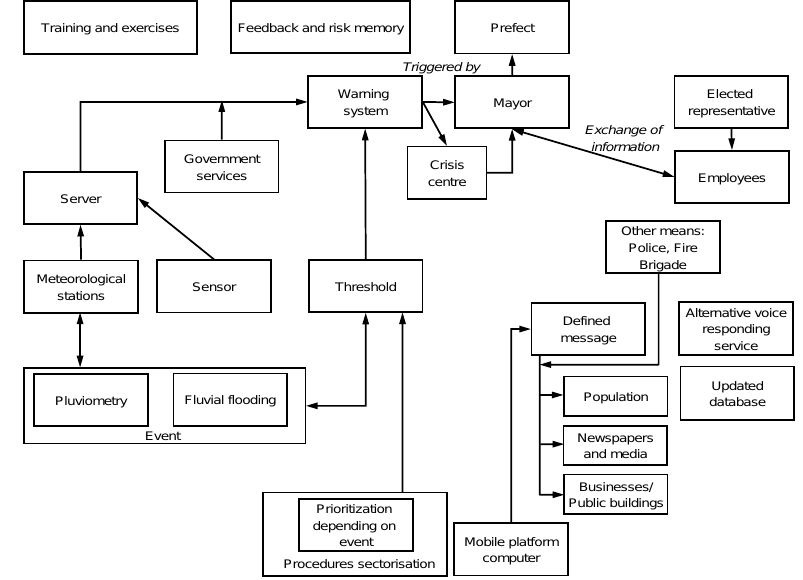
Fig. 7. Entity diagram for flood forecasting for the Tarascon PCS developed during the workshop.